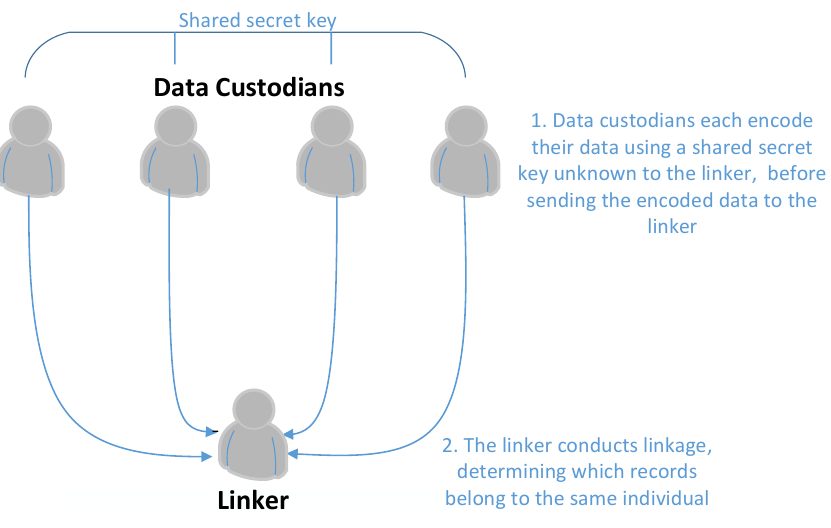
Figure 1: Privacy preserving linkage using an independent third